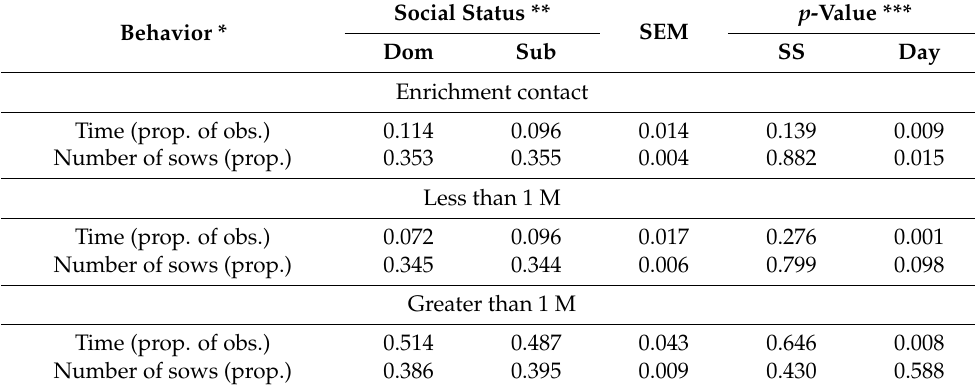
Table 4. Effects of social status and day of observation on time spent near and in contact with enrichment (prop. of observations) and number of sows near or in contact with enrichment (prop. of